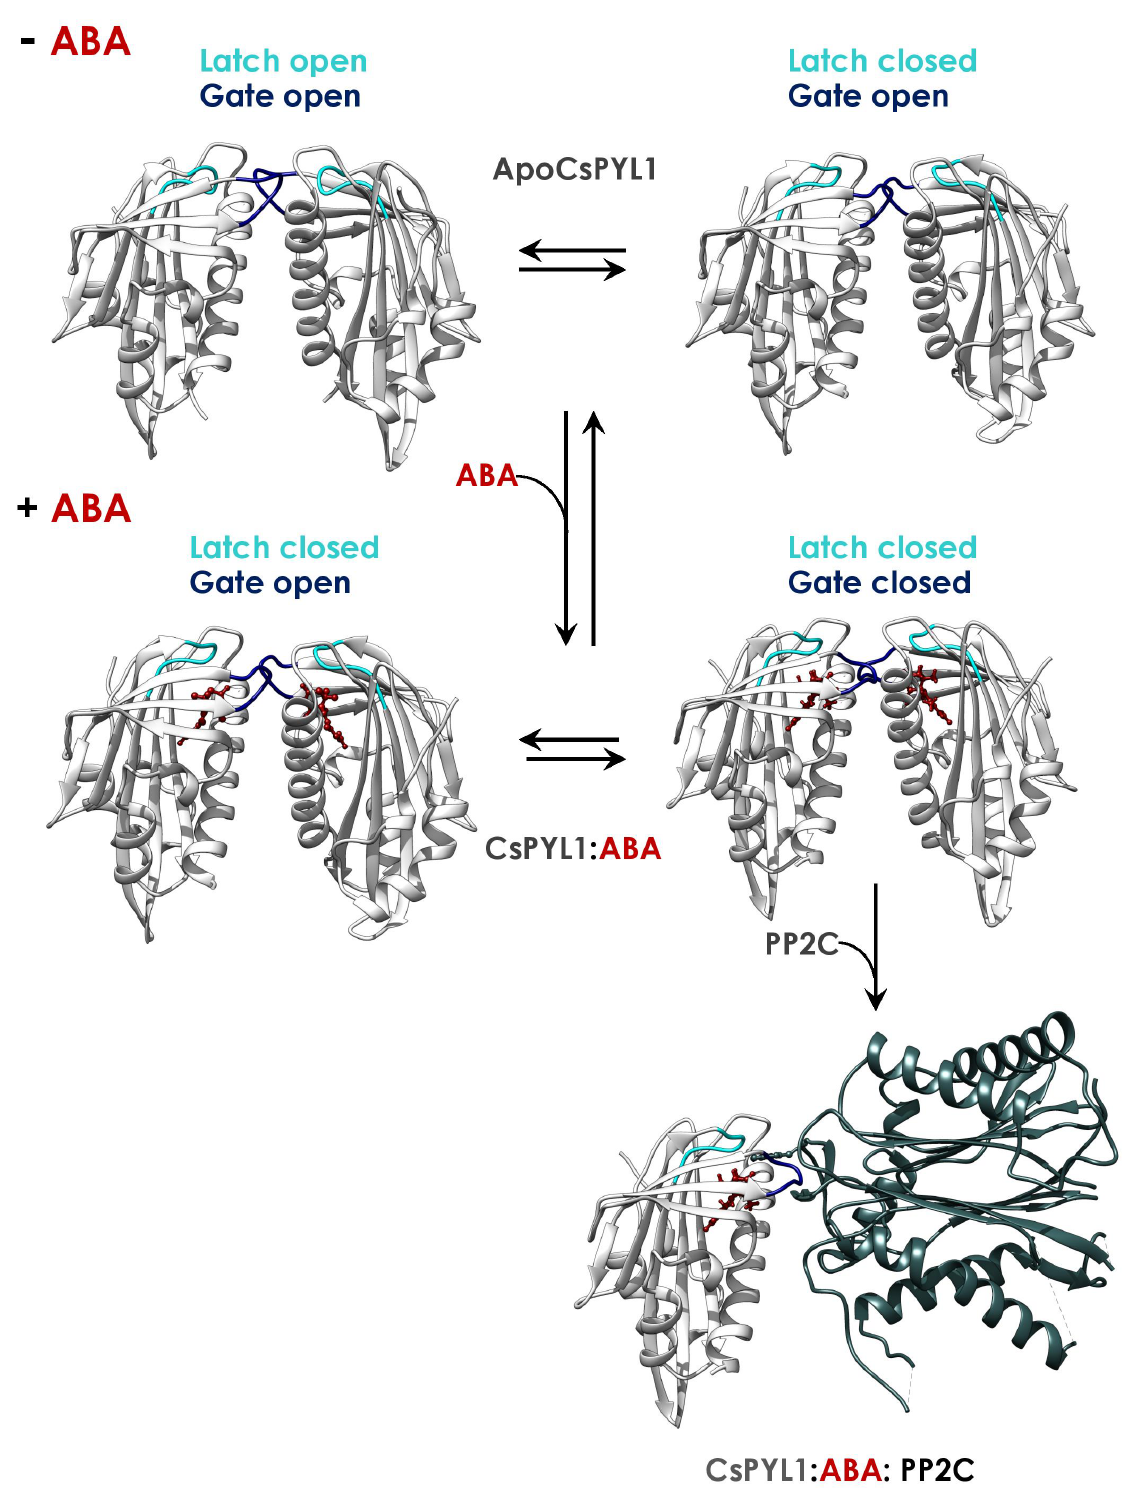
Figure 6. Model of the molecular mechanism for ABA perception. CsPYL1 crystal structures of the apo (PDB ID: 5MMQ), ABA-bound (PDB ID: 5MMX) and ternary complex (PDB ID: 5MN0) forms were used to elaborate this model. Conforma- tional equilibriums of the apo and the ABA-bound forms are represented by horizontal arrows.